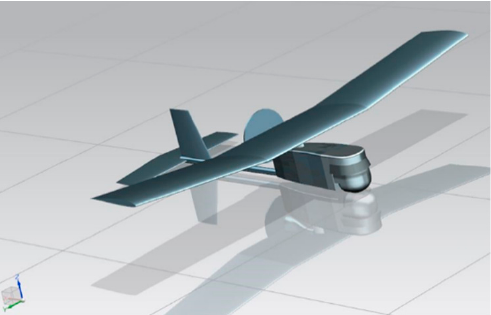
Figure 1. Three-Dimensional Computer Aided Drafting (CAD) model of the RQ-11B Raven, Reprinted from Energy Conversion and Management, 207, Depcik, C., Cassady, T., Collicott, B., Burugupally, S. P., Li, X., Alam, S. S., Arandia, J. R., and Hobeck, J. Comparison of lithium ion Batter-